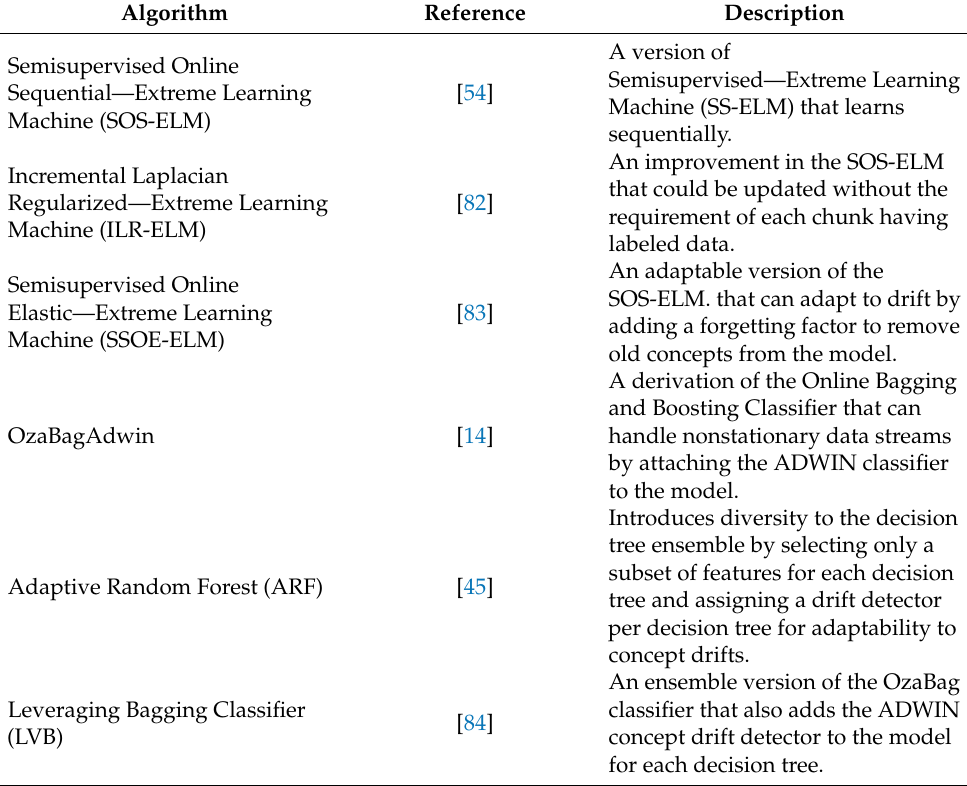
Table 2. Benchmark Algorithms Used in this Study.